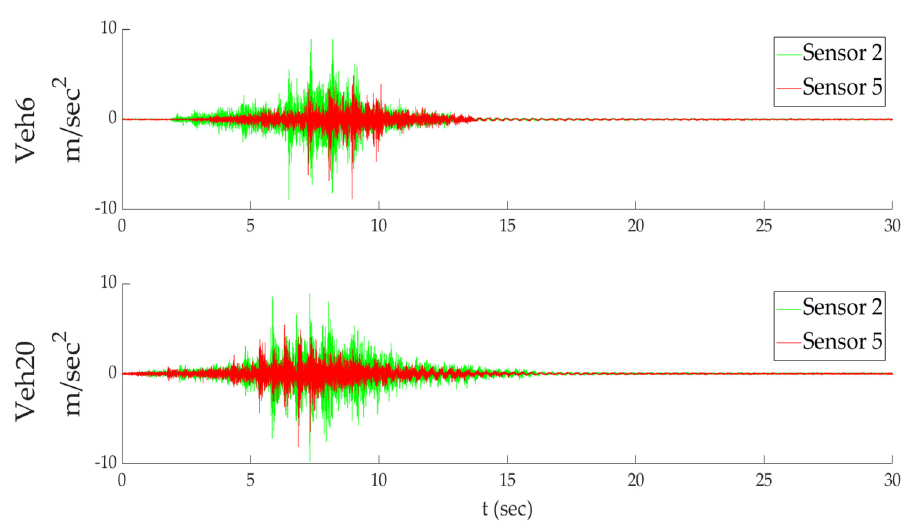
Figure 10. Partial time histories of sensors 2 and 5.